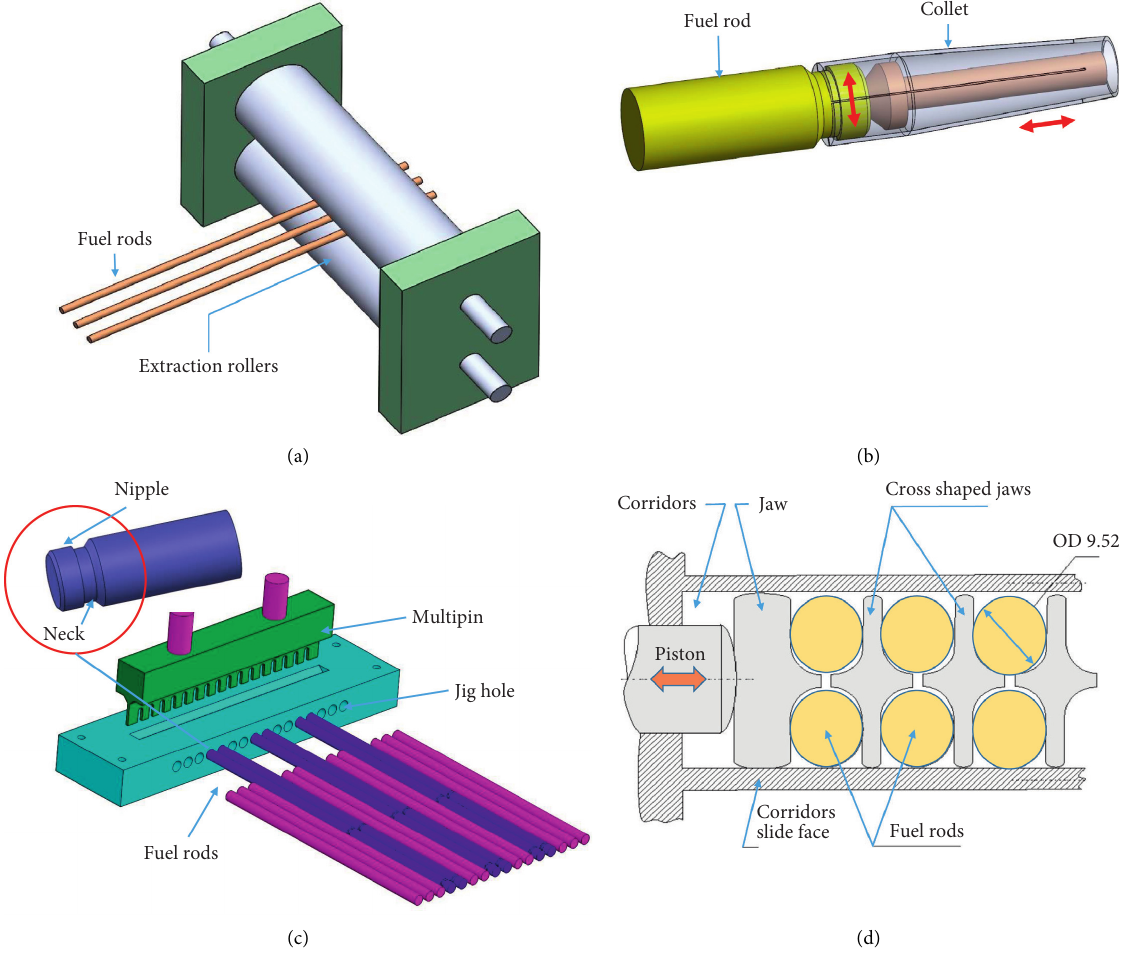
Figure 9: Gripping methods for rod extraction. (a) Roller. (b) Collet. (c) Vertical jaw. (d) Horizontal